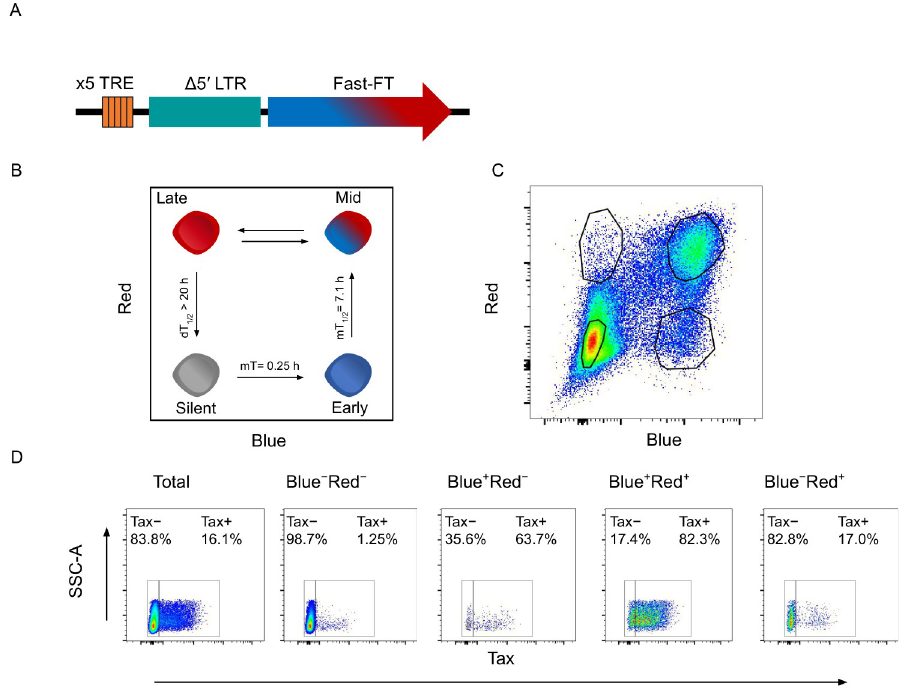
Fig 1. The principle behind Tax-induced Timer protein expression. (A) Tax-responsive reporter construct containing the Timer protein gene Fast-FT . (B) Schematic of Timer protein expression during progression of the HTLV-1 plus-strand burst. (C) Representative gating strategy used to flow-sort four cell populations for RNA-seq analysis. (D) Tax expression in each respective Timer population, quantified by intracellular staining.